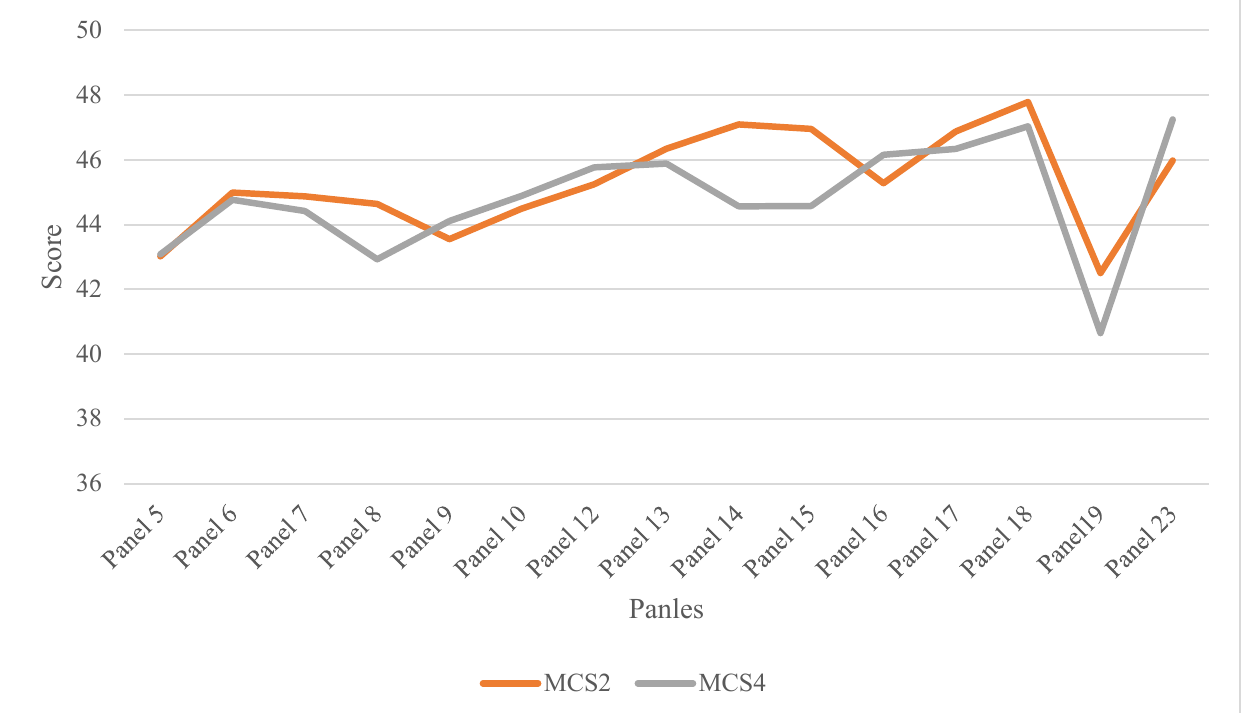
Figure 1. The trend of mental component score (MCS) domain: Panels 11, 20, 21, and 22 are not shown in the graph due to an incomplete record of HRQOL. MCS2: mental component score in round 2, MCS4: mental component score in round 4.